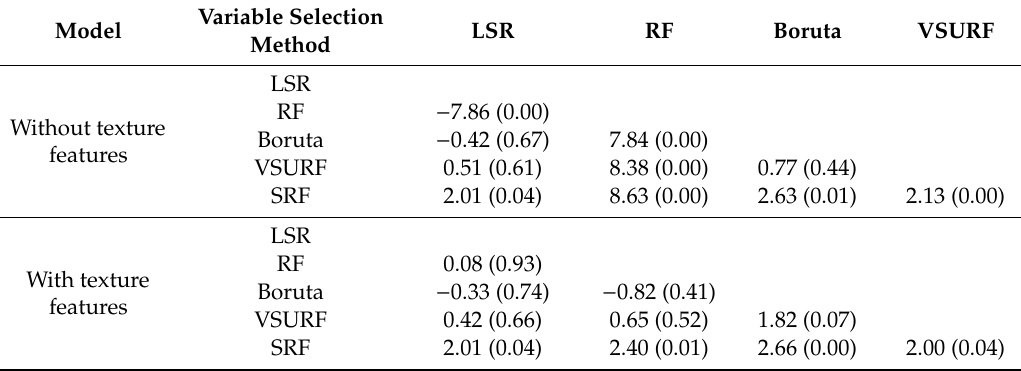
Table 8. The test results ( p -values) of significant di ff erences among the models based on the absolute residuals between the estimated and observed GSV values using student’s t